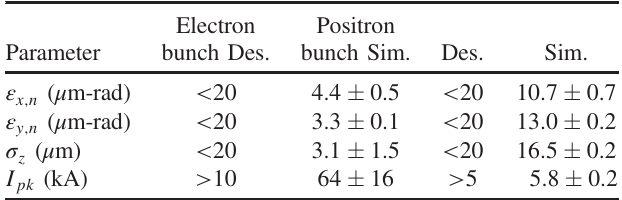
TABLE X. Results from the Monte Carlo tracking simulation study using jitter data from above table. Design requirements and results from 100 seed simulation runs are shown. The simulation results show the mean and rms spread of results obtained. bunch